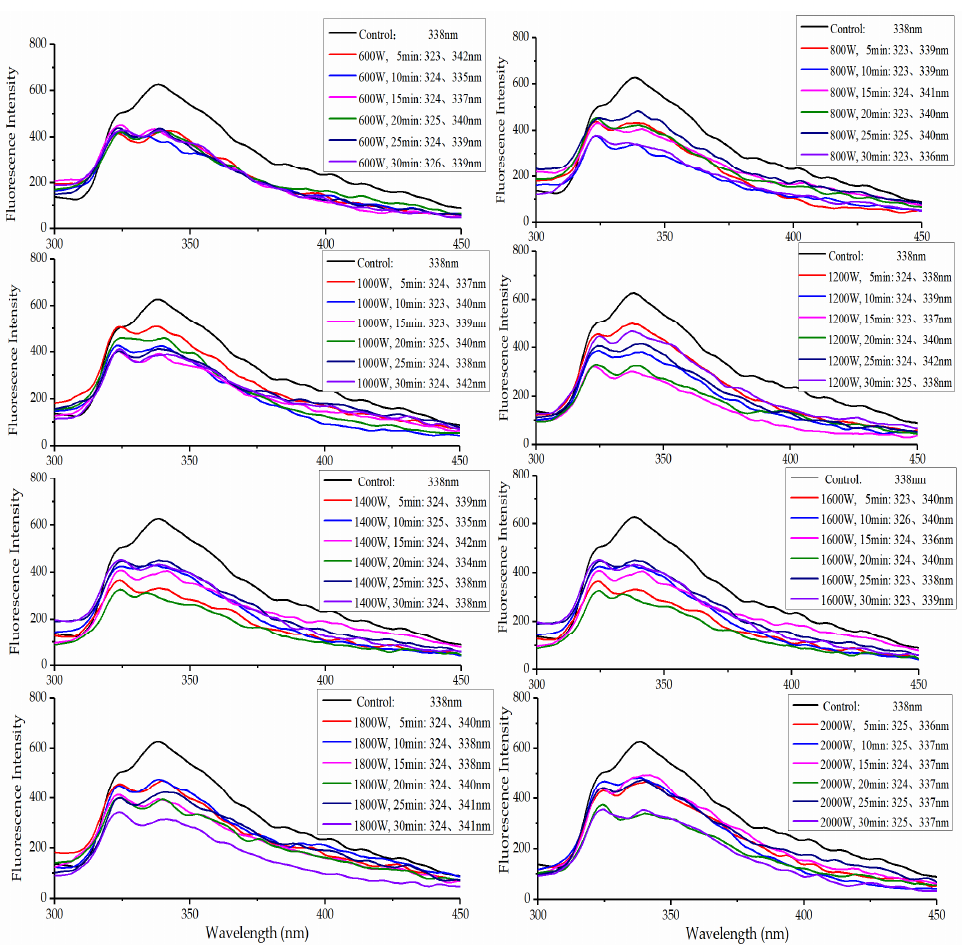
Figure 3. Fluorescence spectra of WPI after HIU treatment.